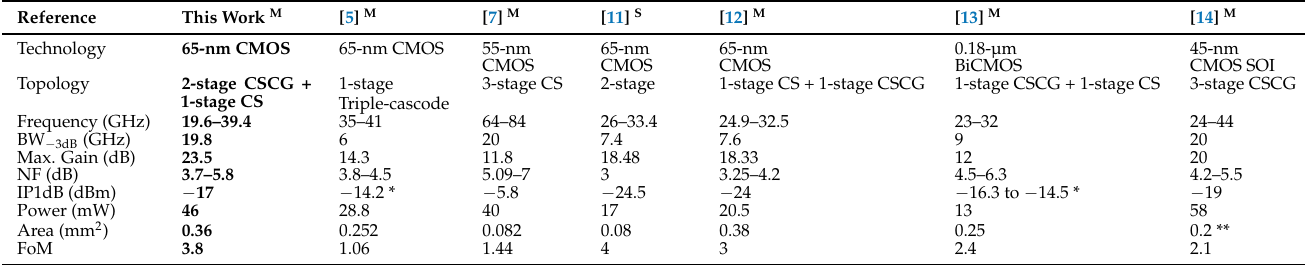
Table 1. Performance comparison with previous